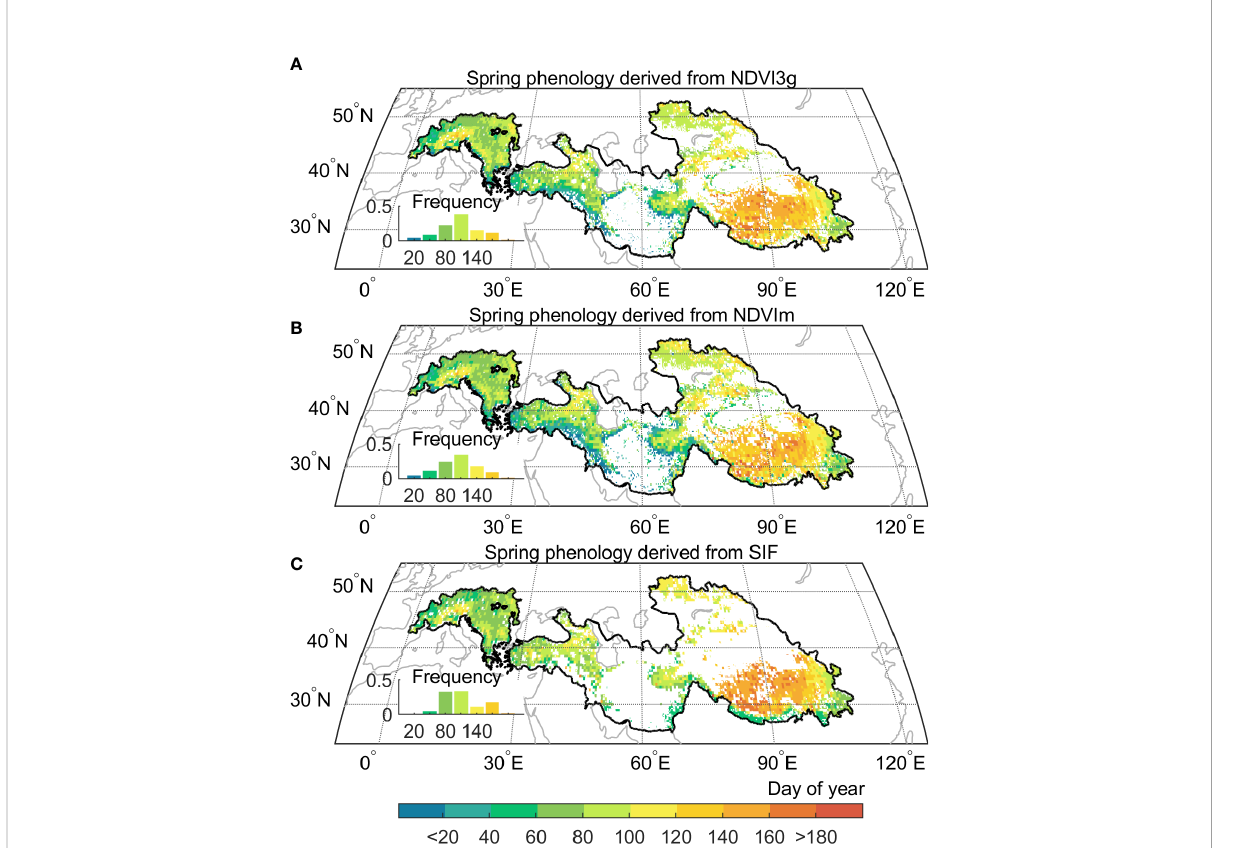
FIGURE 2 Multi satellites-based vegetation spring phenology in the Pan-Third Pole. (A) Spring phenology from GIMMS Normalized difference vegetation index (NDVI3g), and the period is from 1982 to 2015. (B) Spring phenology from Moderate Resolution Imaging Spectroradiometer (MODIS) C6 (NDVIm), and the time period 2001 to 2015. (C) Spring phenology from Solar ‐ Induced chlorophyll Fluorescence (SIF), and the period is from 2007 to 2015. All spatial distribution patterns represent the mean value of their period